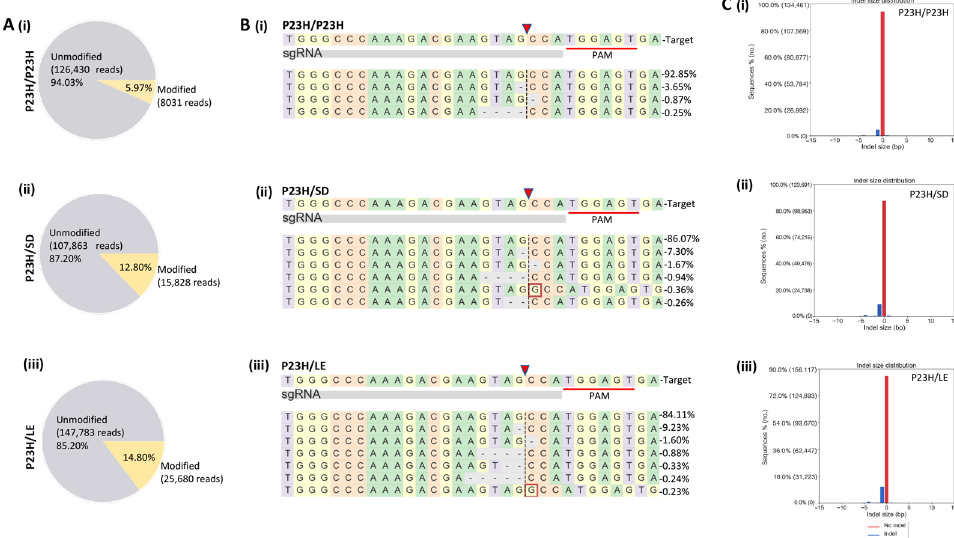
Figure 3. On-target analysis of CRISPR/Cas9-editing in AAV-treated P23H rats. ( A ) Representative Pie charts show the editing efficiency of 5.97% in P23H/P23H ( i ), 12.08% in P23H/SD ( ii ) and 14.8% in P23H/LE ( iii ) rats. ( B ) ( i – iii ) Deep sequencing reads (presented as percent score) show insertions/deletions (indels) at the predicted cleavage site (red arrowhead). The sequence with high reads score is the unmodified sequence, and underlined are the PAMs. The insertions are indicated in the red box and deletions with a dash (-). ( C ) Representative graphs show indel size distribution in P23H/P23H ( i ), P23H/SD ( ii ) and P23H/LE ( iii ) rats.